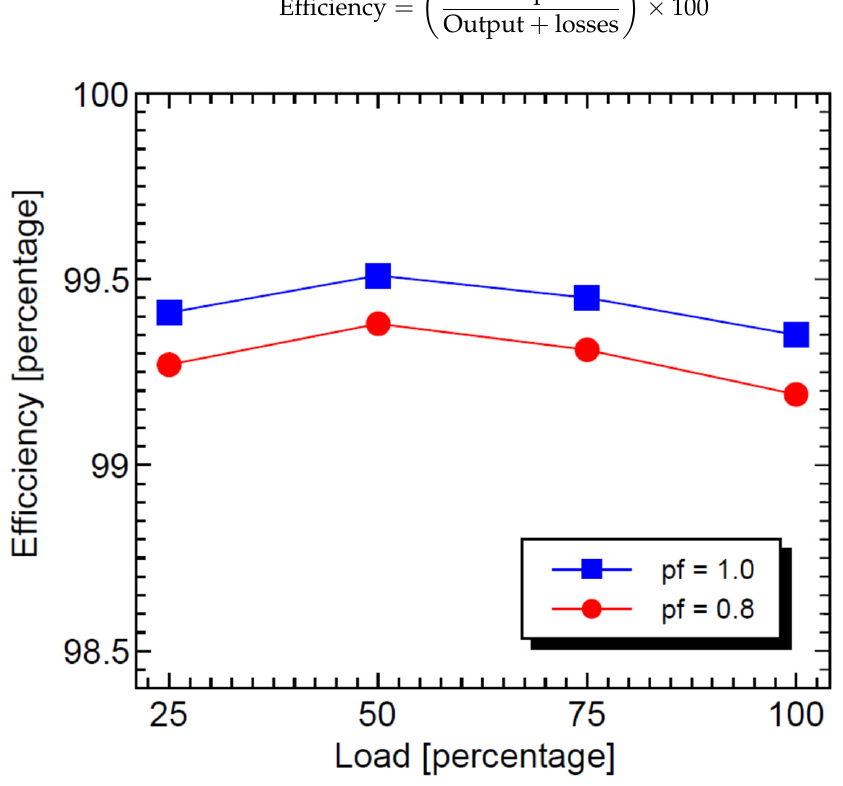
Figure 9. The transformer efficiency when percentage load and power factor change.